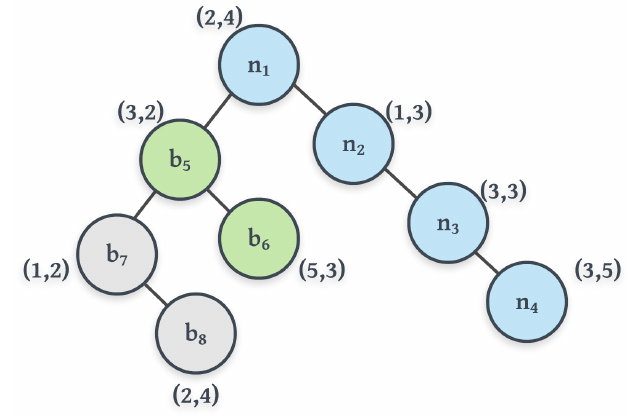
Figure 6. Example SKB tree with three power